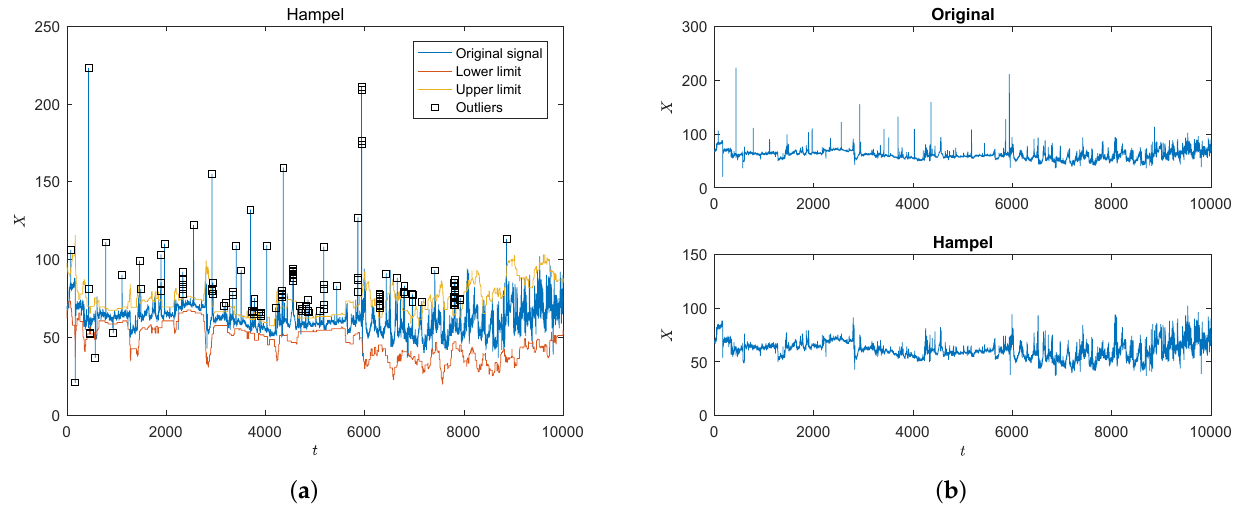
Figure 1. Results of the Hampel filtering procedure for outlier removals ( a ). Original time series (top panel) and processed time series (bottom panel) ( b ). In the last panel the presence of a high non- stationary behavior, such as slow varying cycles, can be observed that needs to be addressed before operating the MFDFA. The bottom panel in ( b ) also shows a set of singularities for the processed signal, such as cuspids and